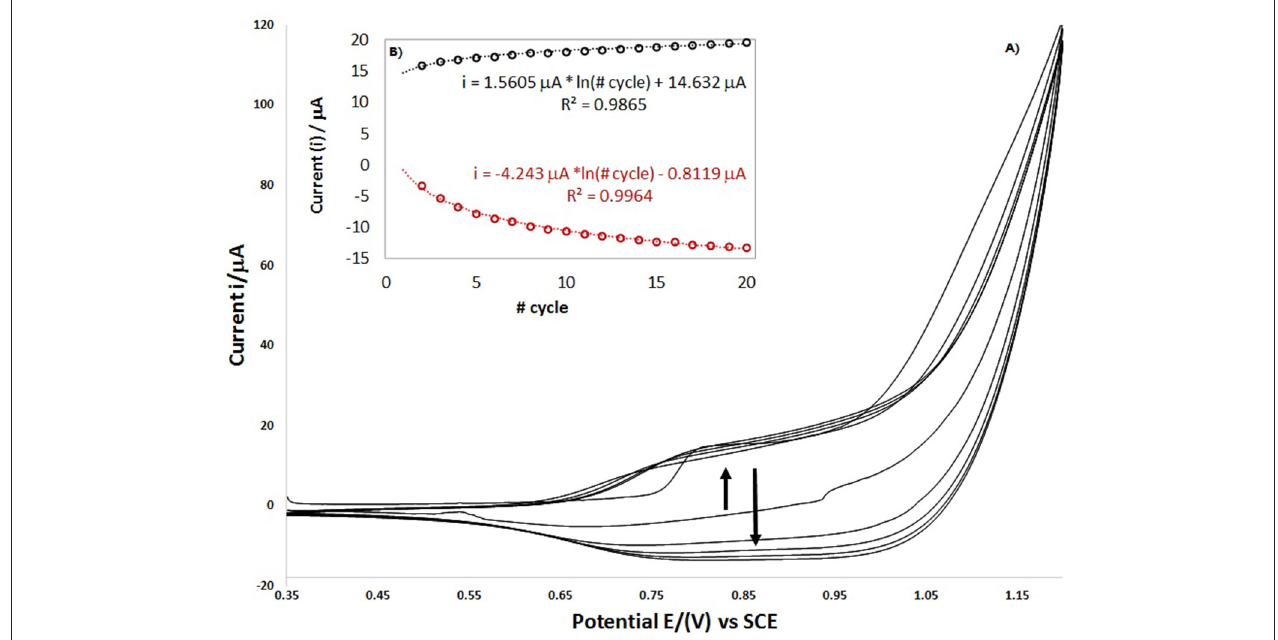
FIGURE 9 | The electrochemical performance of the MCPE using voltammetry data, (A) response of the specific areal Capacitance vs. Scan rate and (B) the Ragone plot of the electrochemical